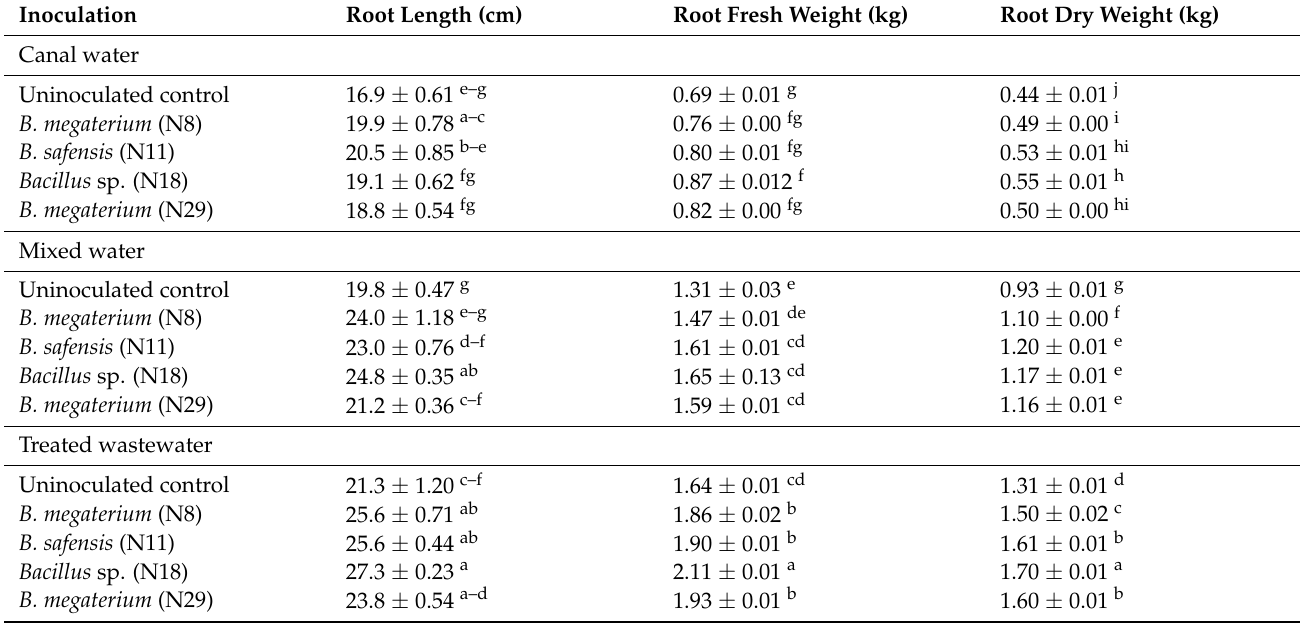
Table 4. Effect of Pb-tolerant Bacillus strains on the root growth of spinach plants under treated wastewater, mixed water, and canal water